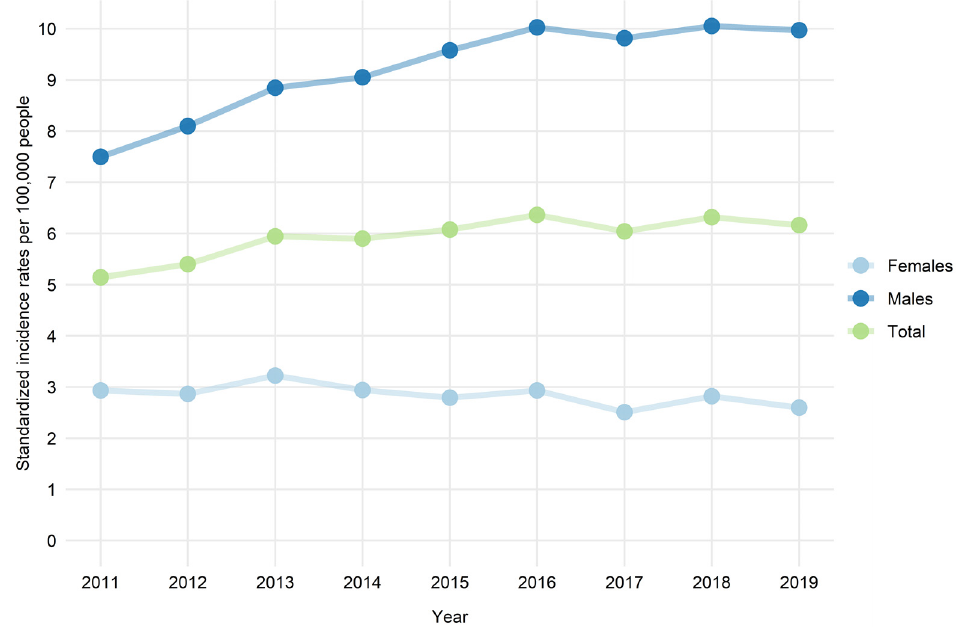
Figure 1. Age and gender distribution of all patients hospitalized for myocarditis in Poland in years 2011–2019. Red— females; blue—males.